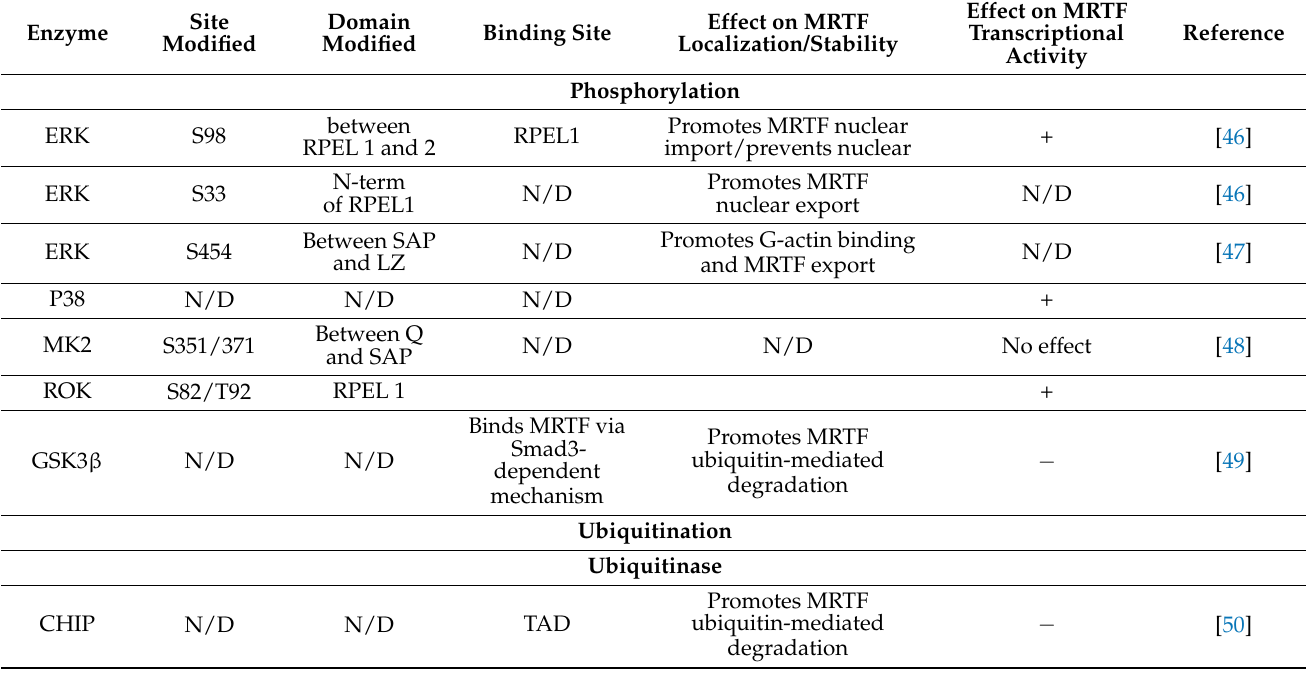
Table 1. Posttranslational modifications/modifiers of MRTF: phosphorylation, acetylation, and SUMOylation. Site Enzyme